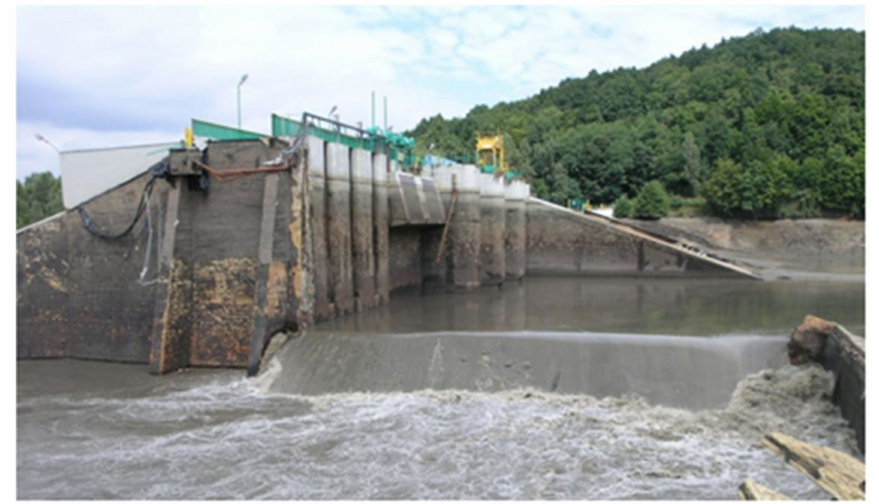
Figure 8. Broken left retaining wall of the control structure on 7 August 2010, time ca.